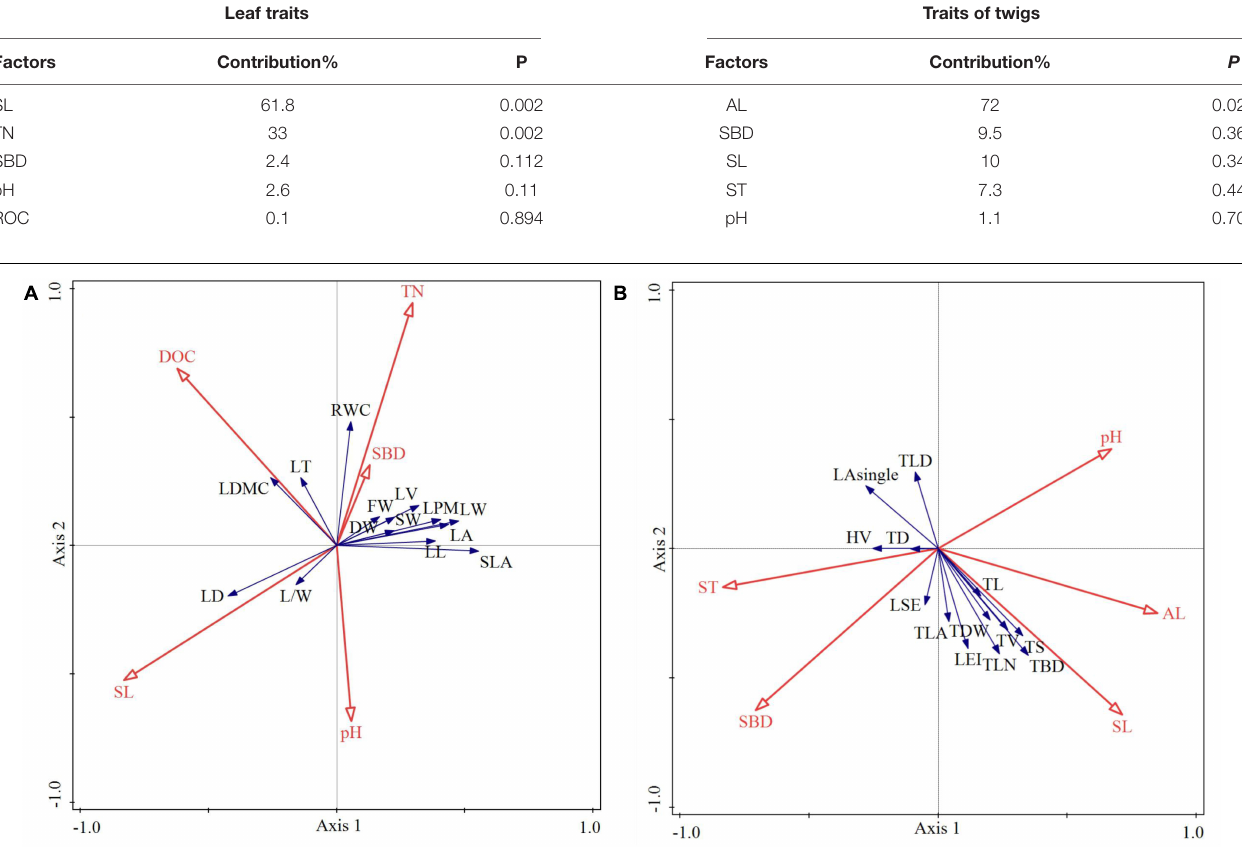
TABLE 5 | Contribution rate and p value of dominant environmental factors to functional traits. Leaf traits